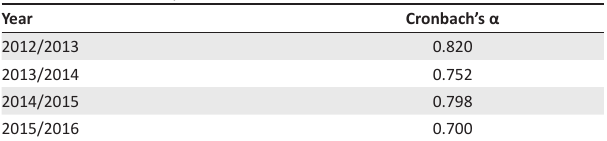
TABLE 7: Cronbach’s alphas for financial scores from 2012/2013 to 2015/2016.